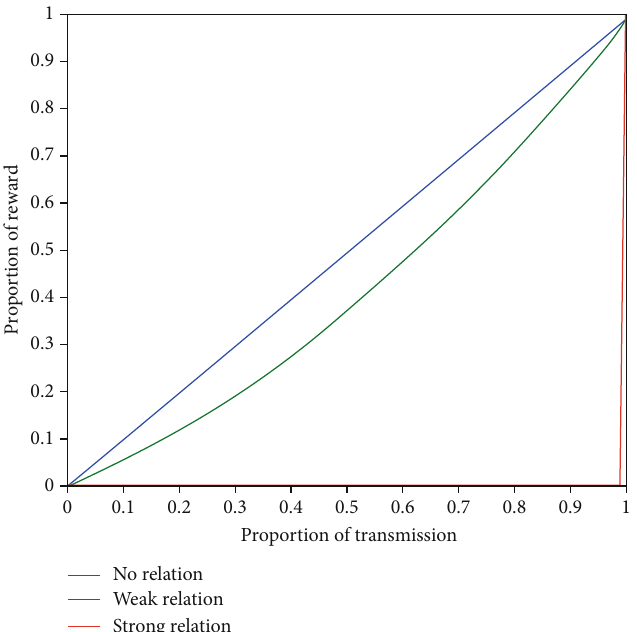
Figure 5: Completeness reward function with di ff erent correlation types. Blue illustrates the data topic of no relation type, which is a linear function and this is the case of a conventional satellite data transmission scheduling problem. The green one illustrates the data topic of a weak relation type, which is a typical convex function. And the red one is a data topic of strong relation type, which is a step function. All the three kinds of data topic requirements are considered in our